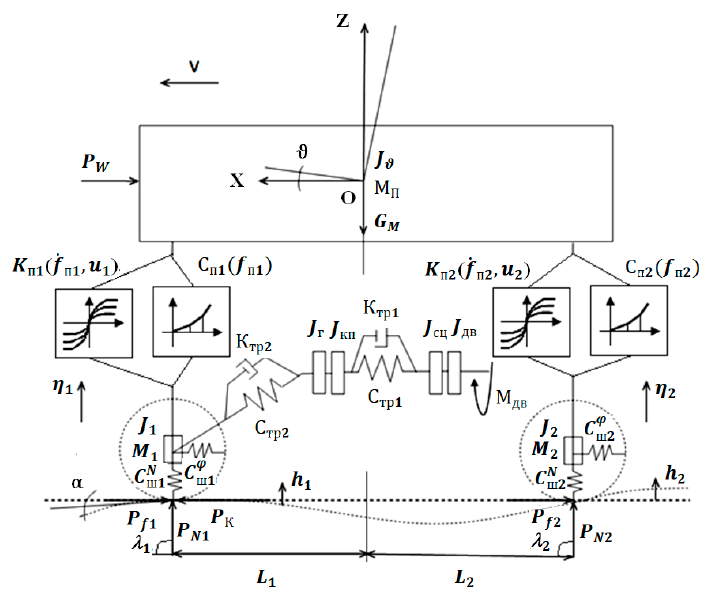
Figure 1. Design diagram of a vehicle with adaptive suspension.